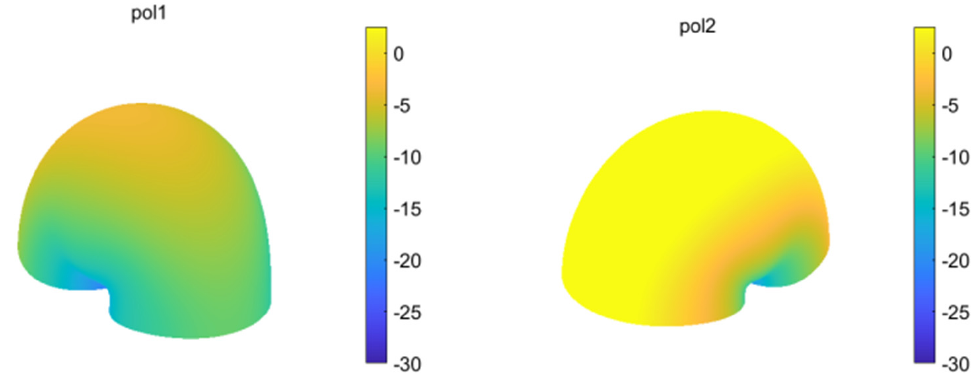
Figure 2. RIS panel phase distribution. ( a ) RIS panel phase distribution for a 1-bit single-polarized panel; ( b ) RIS panel phase distribution for a 4-bit dual-polarized panel. The indoor RIS test was conducted in Shanghai ZTE Park. Figure 3 shows the RIS panel indoor deployment. The BS and RIS were deployed in the corridor and the terminals were deployed indoors. A comparison of the measured and simulated results of the RIS deployment indoors is shown in Figures 4 and 5. Figure 4 shows a comparison of the measured and simulated results of the 1-bit single-polarized panel and Figure 5 shows a comparison of the measured and simulated results of the 4-bit dual-polarized panel.